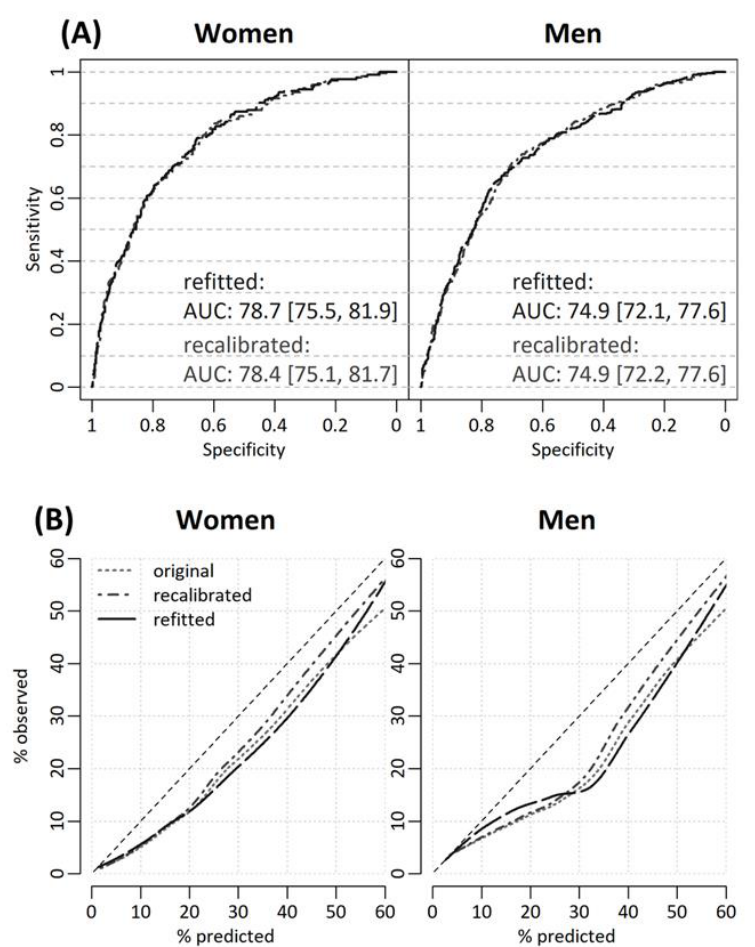
Figure 3. Discrimination and calibration performance of FRS30y for women and men. ( A ) upper row: ROC curves with Area Under the Curve (AUC) as measure of discrimination. As discrimination performance is not affected by recalibration, AUC values for original and recalibrated version are identical and thus the original version is not plotted. ( B ) lower row: smooth calibration based on